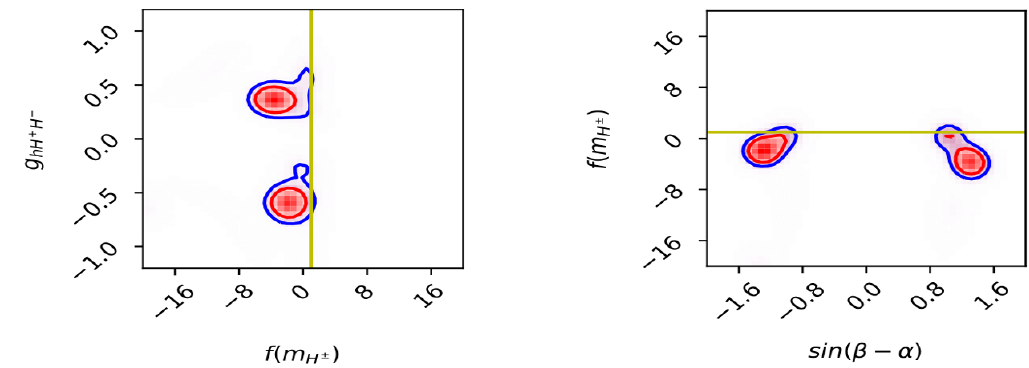
Figure 14 . Allowed regions at 1 (cid:27) (red) and 2 (cid:27) (blue) levels in the parameter space of f ( m g (left) and sin( (cid:12) (cid:0) (cid:11) ) (cid:0) f ( m hH + H (cid:0)